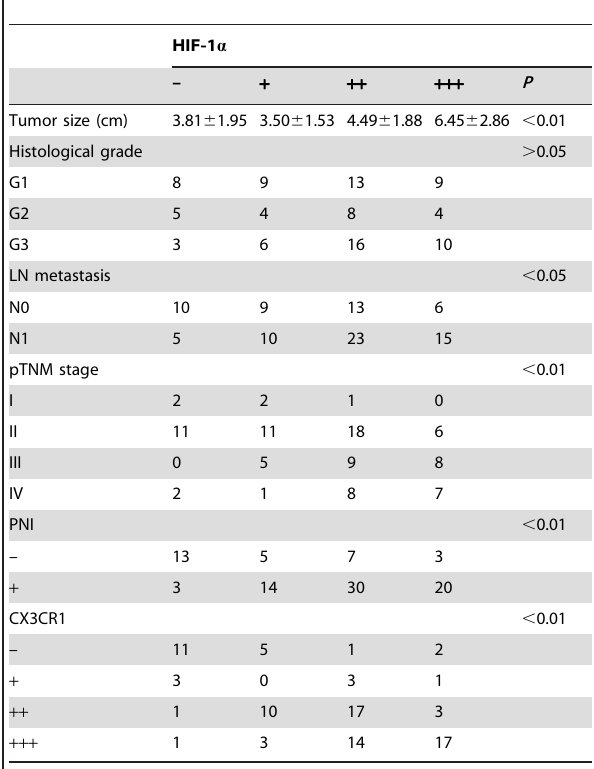
Table 1. Correlation of HIF-1 a expression to clinicopathological features in